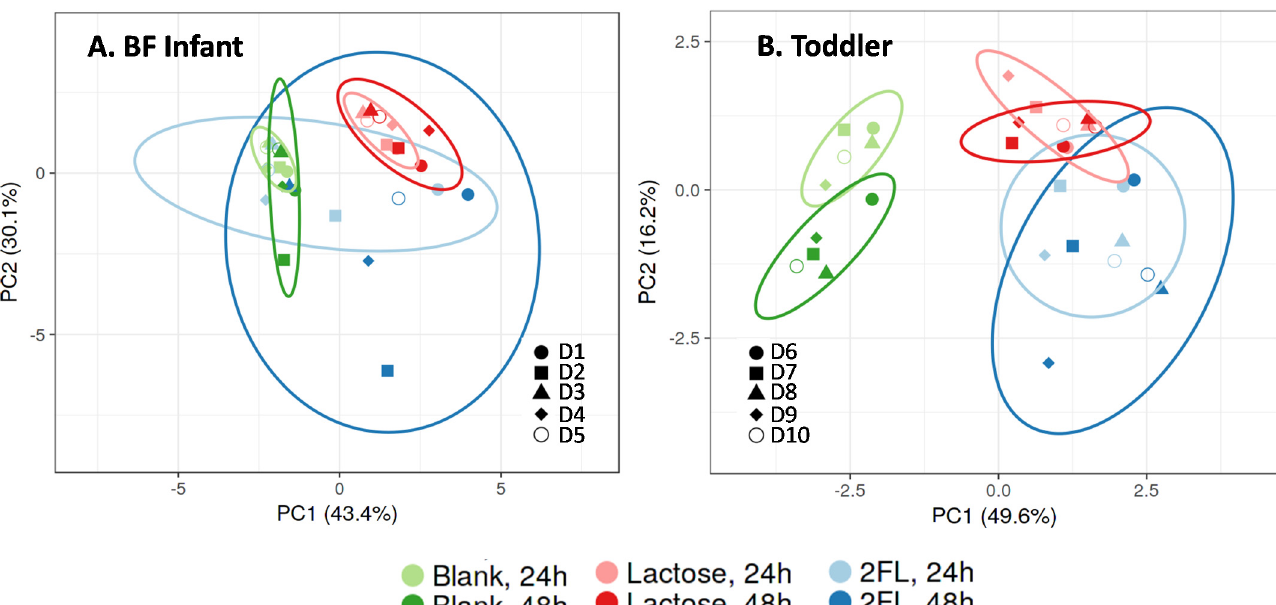
Figure 4. Effect of lactose or 2’-FL on microbial activity and Bifidobacterium populations short-term colonic incubations. Principal component analysis (PCA) plots for ( A ) BF infant fecal samples ( n = 5, 1 each from 5 individual donors) and ( B ) toddler fecal samples ( n = 5, 1 each from 5 individual donors) representing metabolic data (pH, gas, SCFA, BCFA, and lactate) and Bifidobacterium levels obtained for blank control, lactose, or 2’-FL treatments after 24 h and 48 h. Ellipses indicate clusters identified after automatic classification based on PCA scores at 95% confidence interval. BCFA, branched-chain fatty acid; BF = breastfed; 2’-FL = 2’fucosyllactose; D = donor; PC = principal component; SCFA, short-chain fatty acid.